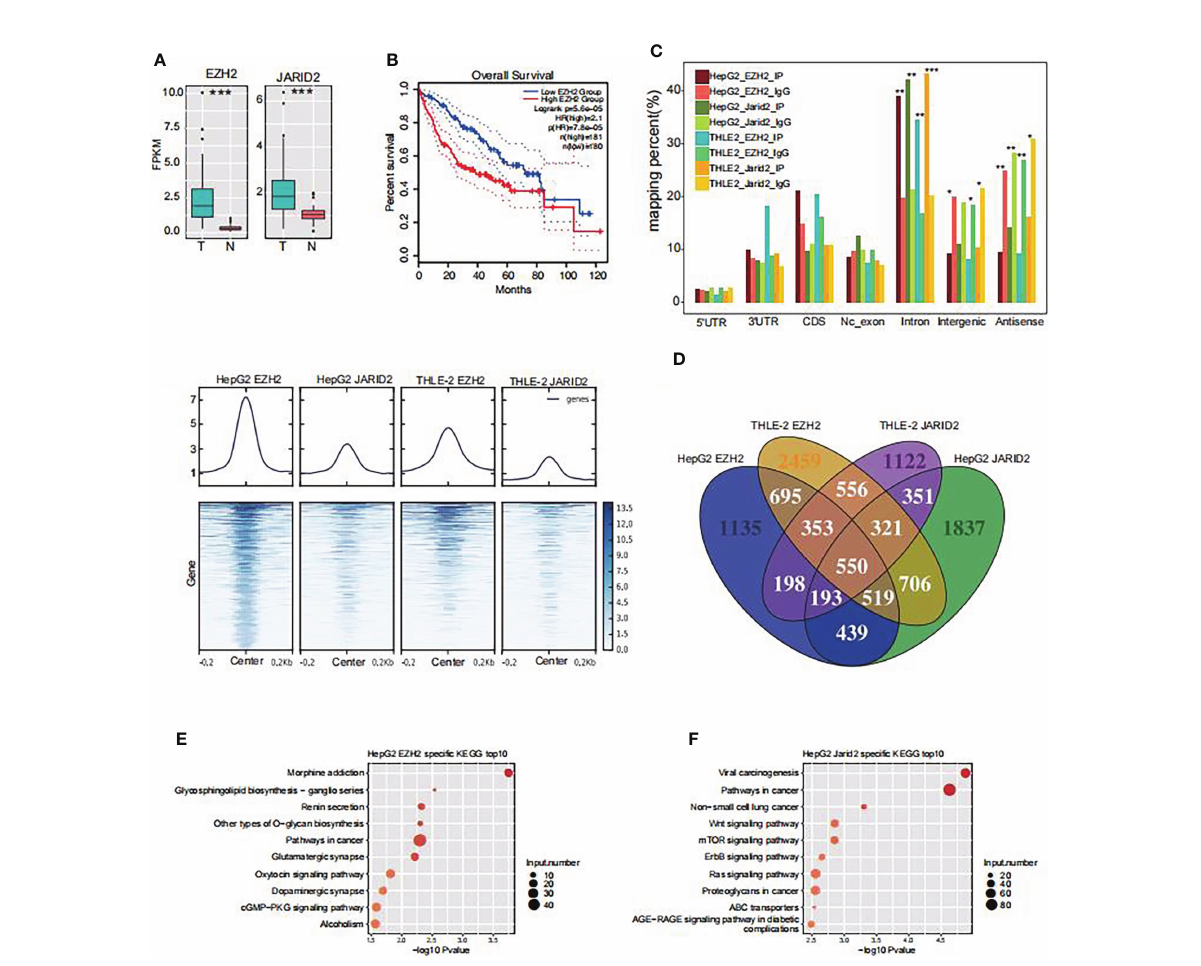
FIGURE 1 The RNA binding pro fi les of EZH2 and JARID2 in HepG2 and THLE-2 cell lines, respectively. (A) Box plot showing the transcriptional level of EZH2 and JARID2 in HCC tumor and adjacent normal samples from TCGA database. FPKM, Fragments Per Kilobase of exon model per Million mapped fragments. (B) Overall survival in Liver Hepatocellular Carcinoma patients with different expression levels of EZH2 and JARID2. (C) Heat map presentation of all eight samples reads density around the center of peaks from HepG2 JARID2 sample. (D) Venn diagram showing the overlapped genes among the bound genes by EZH2 and JARID2 in HepG2 and THLE-2 cell lines. (E) Bubble plot showing the top ten enriched KEGG pathways for genes speci fi cally bound by EZH2 in HepG2 cells compared with THLE-2 cells. (F) Bubble plot showing the top ten enriched KEGG pathways for genes speci fi cally bound by JARID2 in HepG2 cells compared with THLE-2